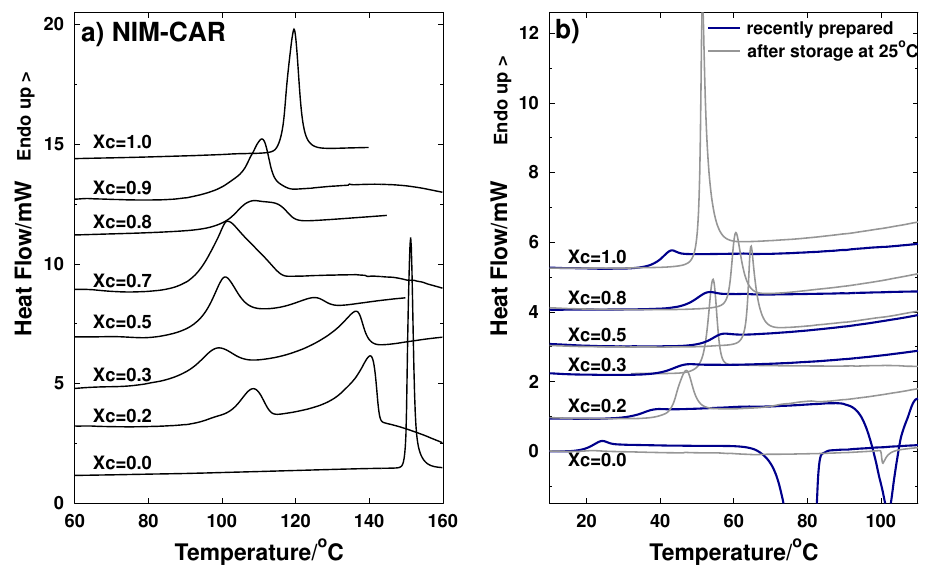
Figure 3. Thermograms of the NIM-CAR binary system obtained by DSC. The mole fractions are expressed in terms of carvedilol ( X c ) ( a ) crystalline samples ( b ) amorphous samples: plots with blue lines correspond to the measurement of the glass transition temperature performed immediately after the quenching of the molten sample. Thin gray lines correspond to the measurements carried out after 85 days of storage (at 25 ◦ C), except for sample X c = 0.3 in which storage time corresponds to 39 days . Heating rate was 10 ◦ C/min in all